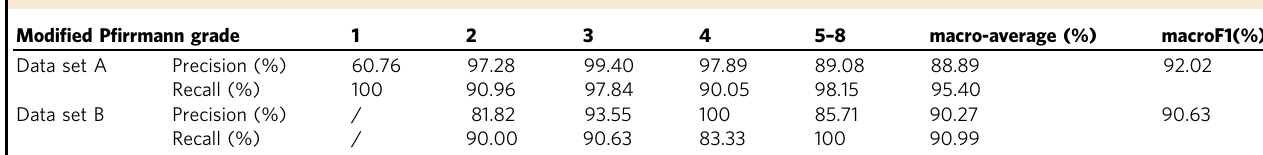
Table 5 Accuracy of IVD degeneration grading with Δ SI in